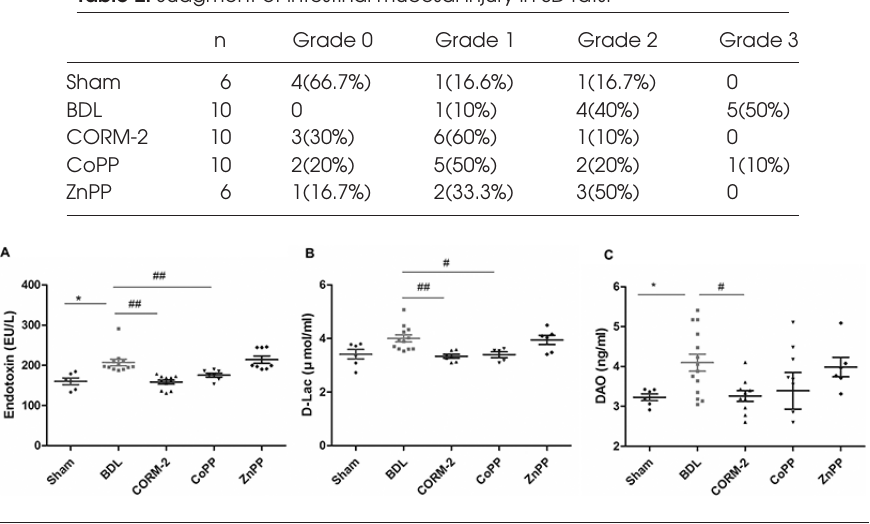
Table 2. Judgment of intestinal mucosal injury in SD rats.